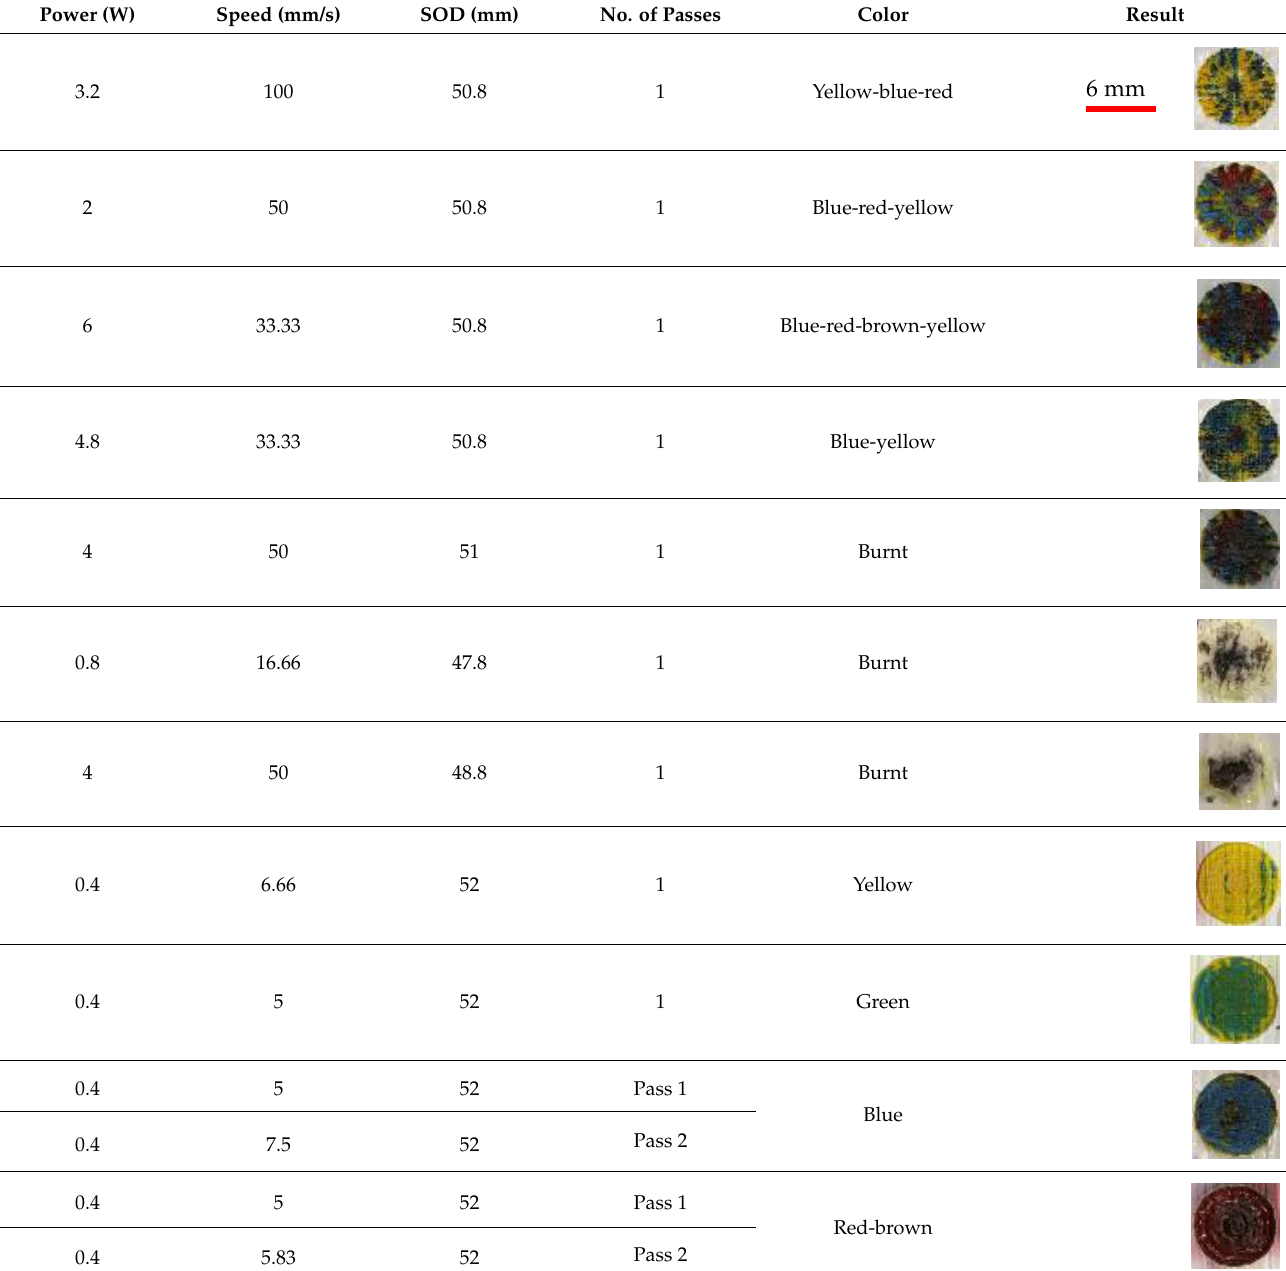
Table 2. Preliminary result of laser discoloration with different laser powers, speeds, and SODs.